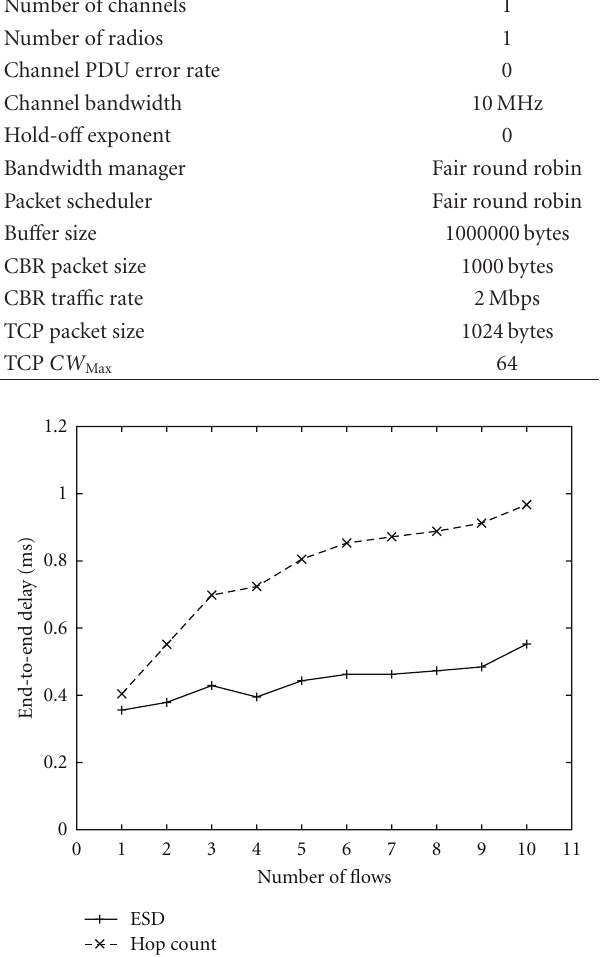
Figure 3: Delay comparison: ESD metric versus hop count.